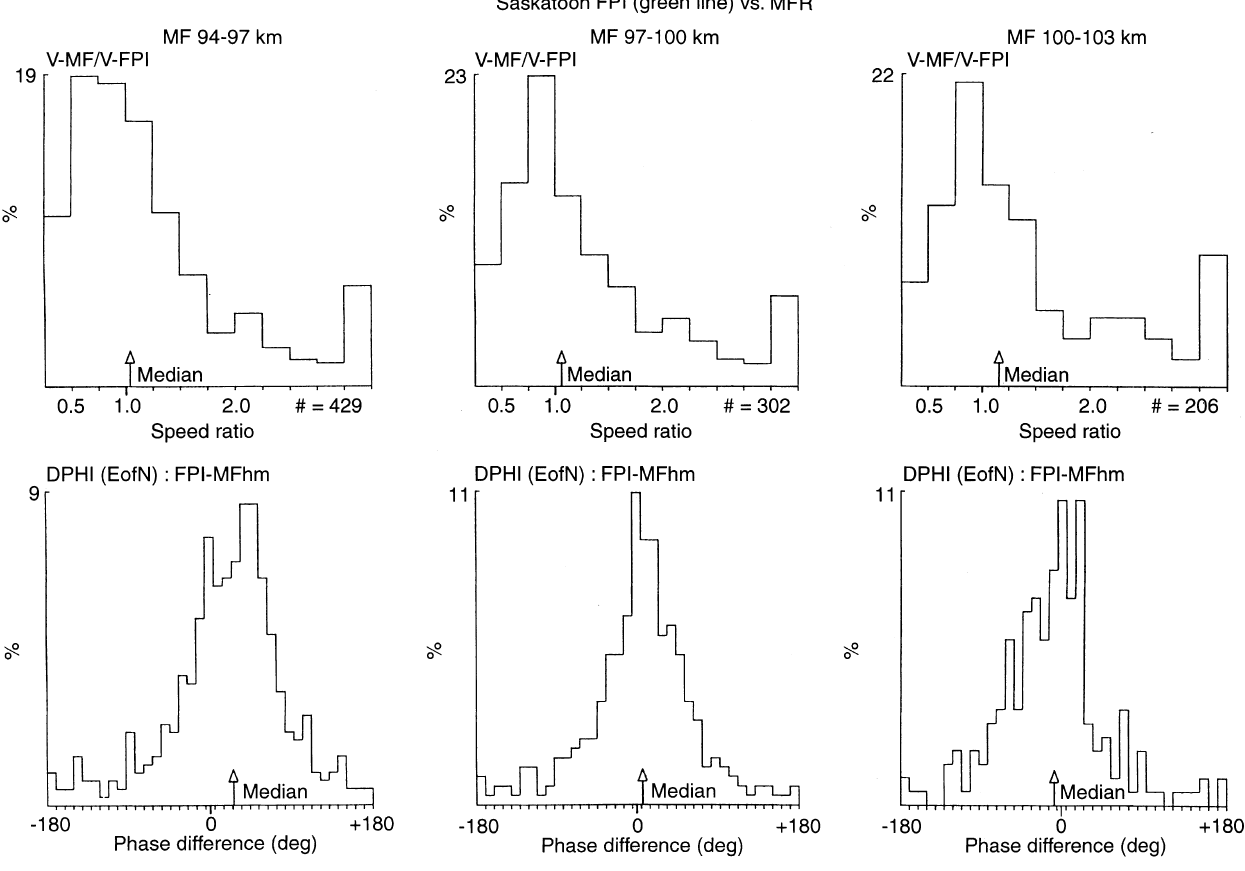
Fig. 1. Saskatoon FPI (green line, nominally at 97 km) compared with three two-height layers of MFR data: 94–97, 97–100, and 100–103 km (hourly means with # > 6). Speed-ratio ( top ) and-direction di(cid:128)erence (10 (cid:14) bin, bottom )